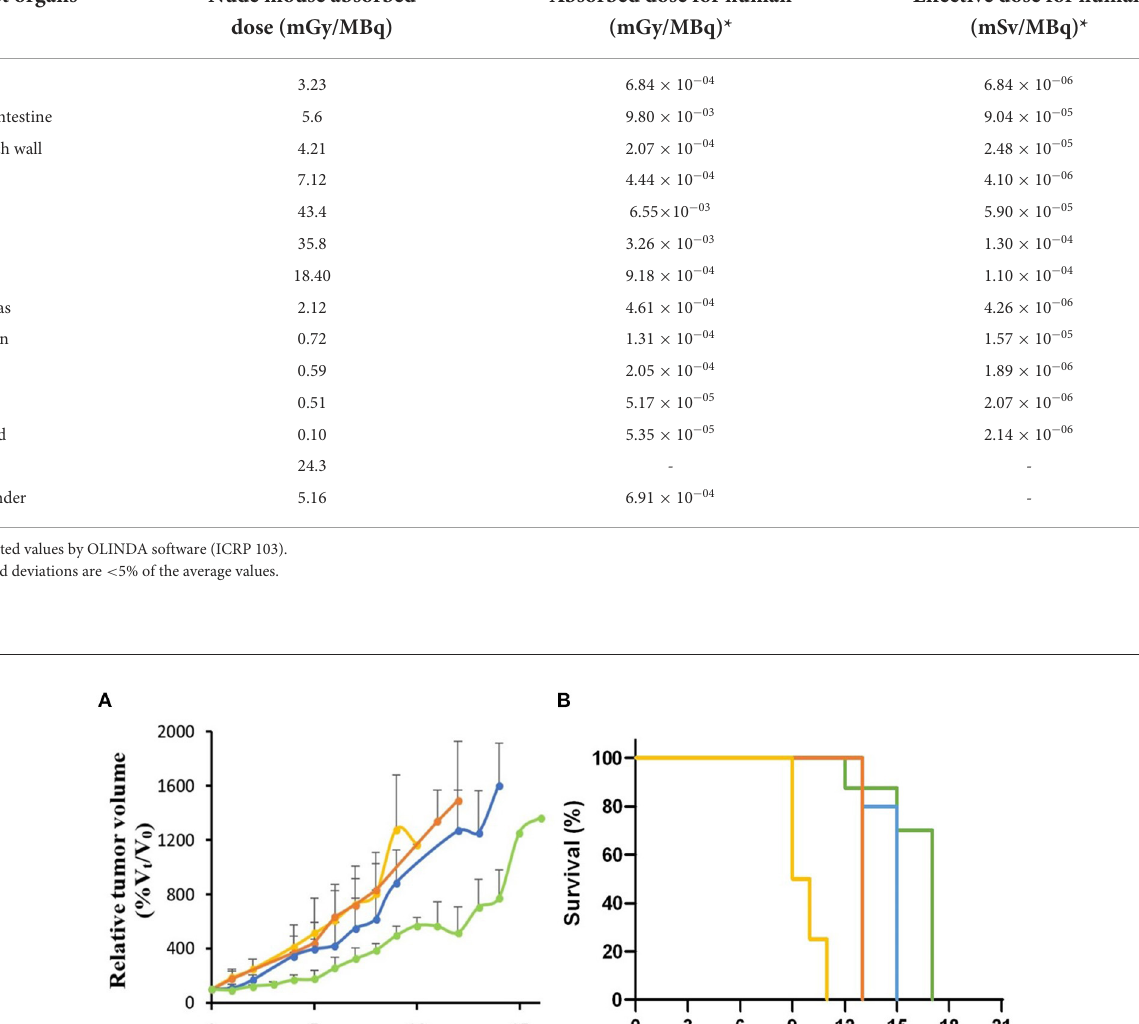
TABLE 2 Comparison of estimate absorbed dose of nude mice and human from [ 64 Cu]NOTA-TP based on nude mouse biodistribution and PET-derived uptake data ( n = 4). Target organs